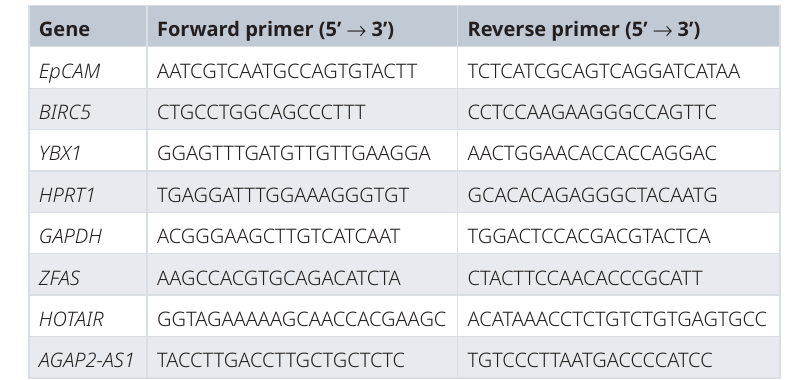
Table 1. Primers used for quantitative